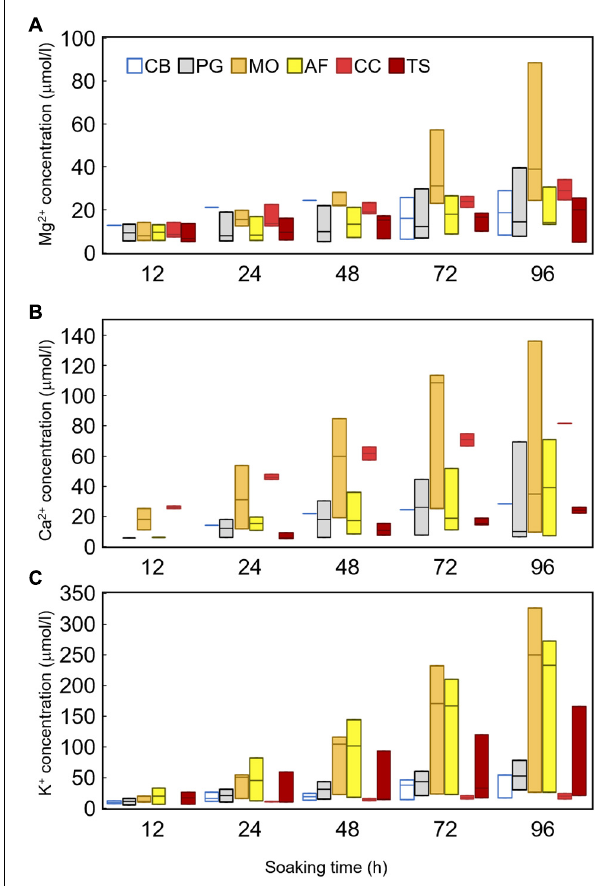
FIGURE 3 | Box-plot of concentrations of inorganic ion, (A) Mg 2 + , (B) Ca 2 + , and (C) K + extracted from the bark by soaking experiment. Colors mean each species as Clethra barbinervis (white), Padus grayana (gray), Magnolia obovata (orange), Abies firma (yellow), Castanea crenata (light red), and Tsuga sieboldii (deep red). Bars in figure are SD.